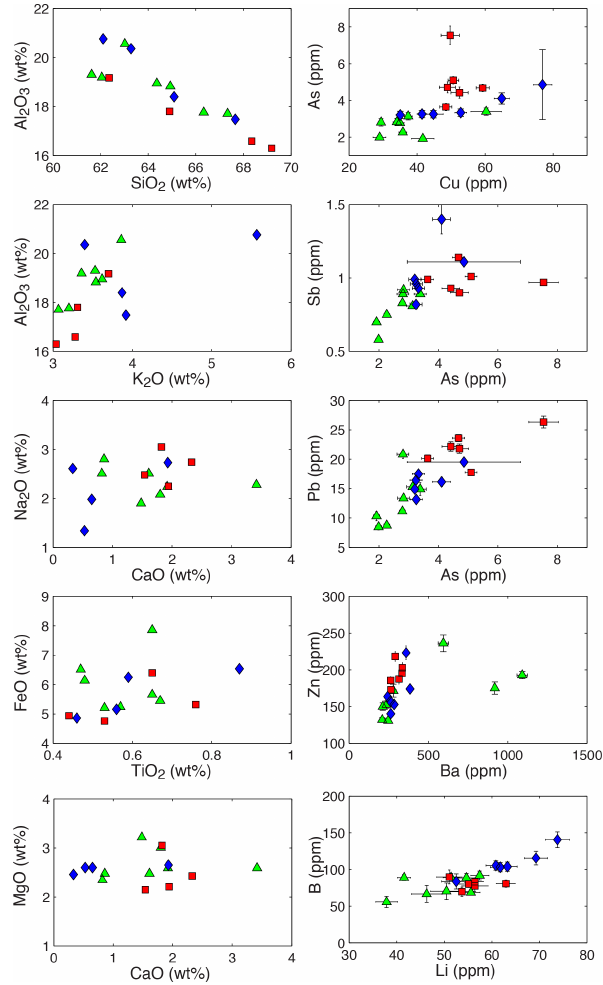
Figure 11. Averaged major-element concentrations represented as oxides (samples 4R-3, 73-76; 11R-6, 3-8; and 21R-2, 82-85) and trace-element concentrations (21R-2, 82-85) in the matrix (green triangles), in shear zones (red squares), and in veins (blue dia- monds) after normalization of the sum of major oxides to